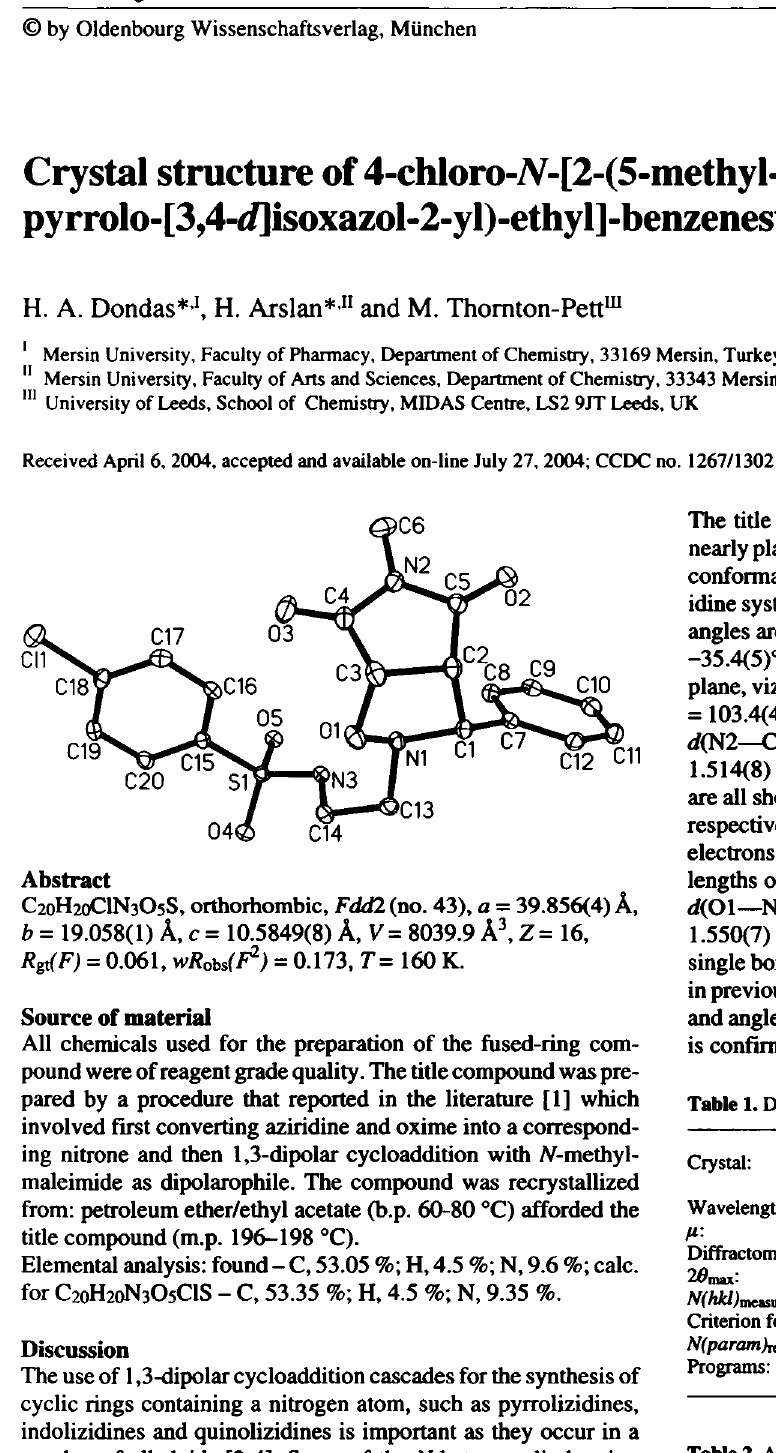
Table 2. Atomic coordinates and displacement parameters (in Â 2